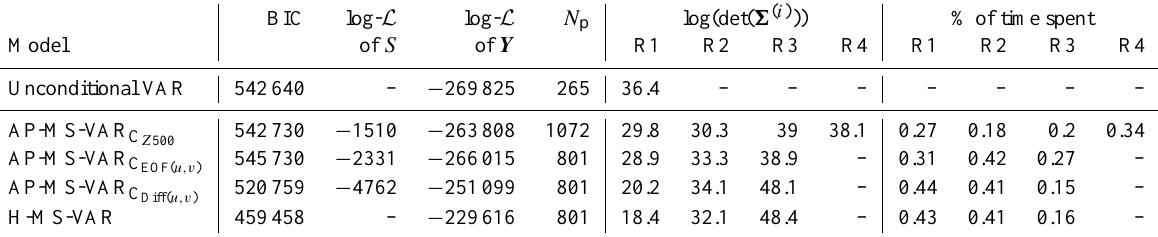
Table 2. N p is the number of parameters. Values are computed from models fitted on { u t ,v t } at the five locations (1, 6, 10, 13, 18). BIC